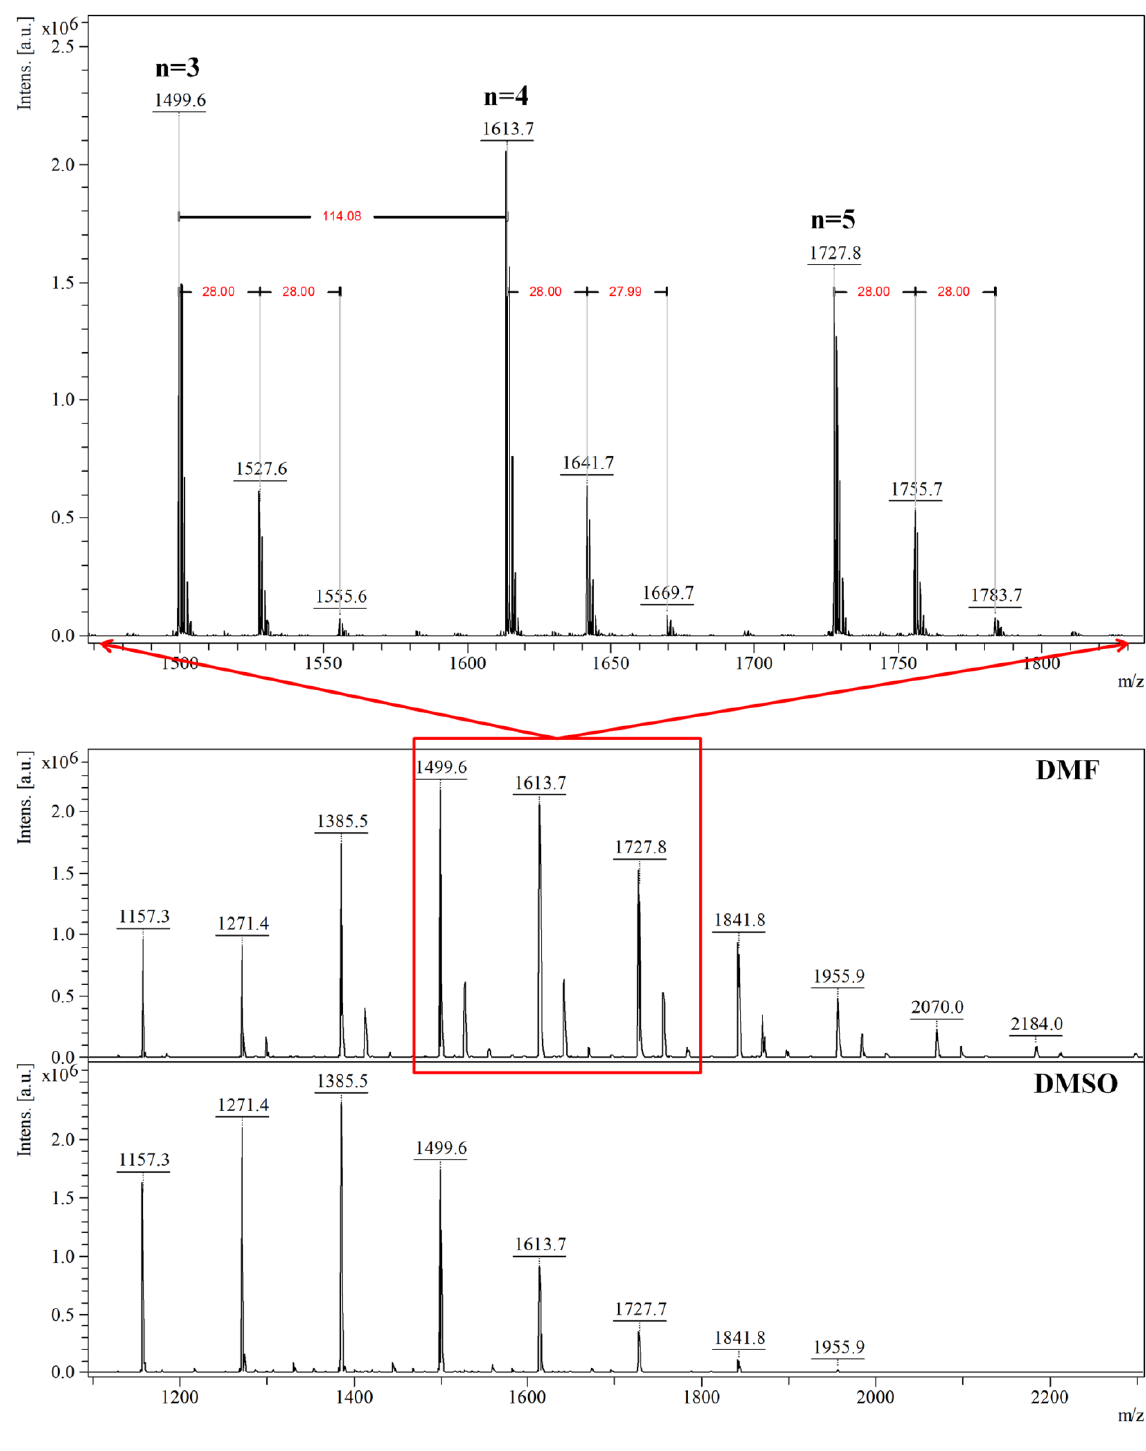
Figure 8. Mass spectra of CDCL in DMF and DMSO (#4, 1) .